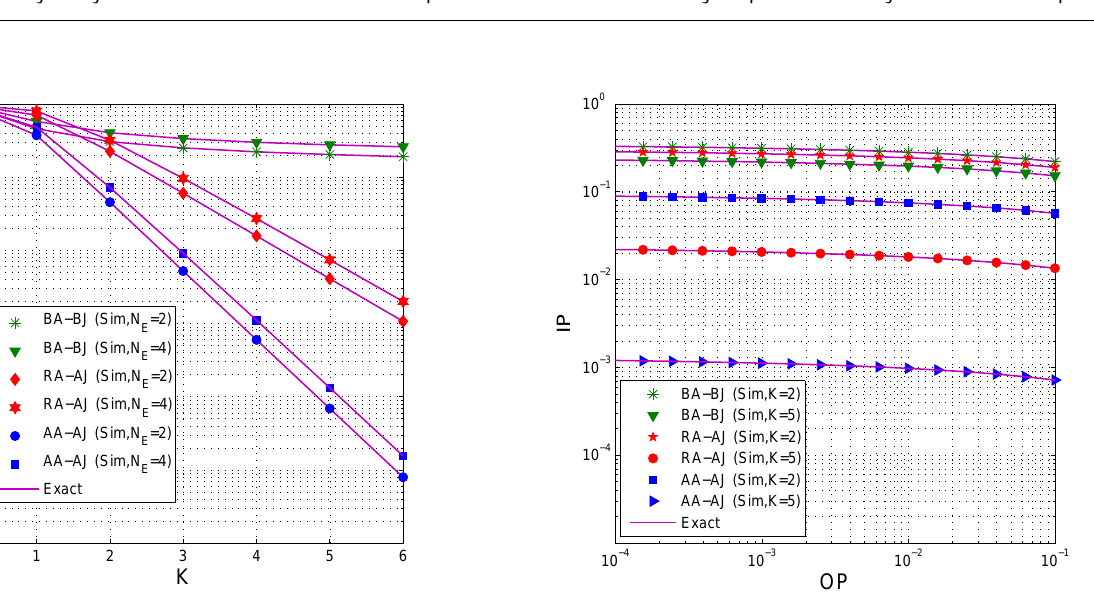
, N , th = 1 . 25 T = 2 = µ 2 = 0 . 01 . E D